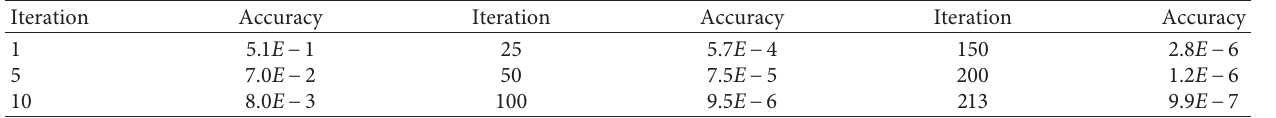
Figure 2: Convergence curves of the EV-MSA algorithm ( ε � 10 − 6 ). Table 1: Accuracy at specific iterations.